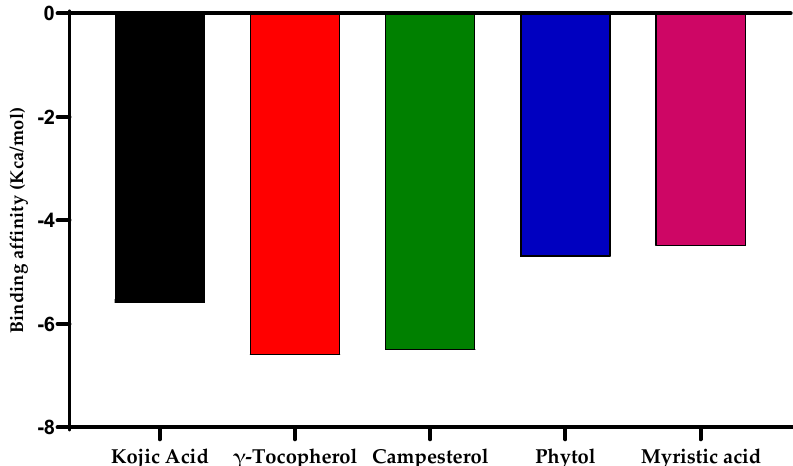
Figure 11. The binding affinity of kojic acid, γ -tocopherol, campesterol, phytol, and myristic acid.